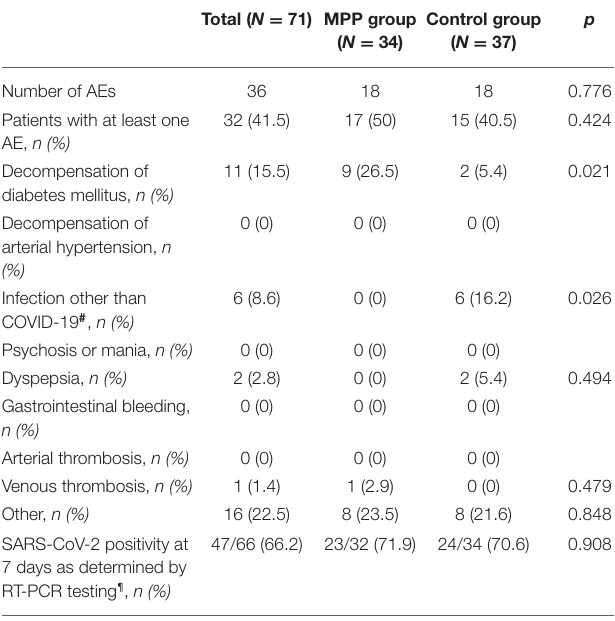
TABLE 3 | Adverse events at day 28.